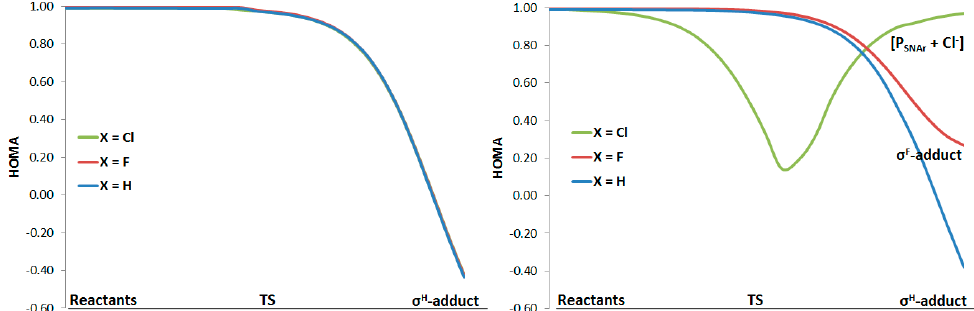
Figure 2. Th e Harmonic Oscillator Model of Aromaticity (HOMA) aromaticity index for the addition to the ortho ( left ) and para position ( right ), calculated at PBE1PBE/6-31 + G(d) level of theory (P SNAr stands for the product of the S N Ar reaction).